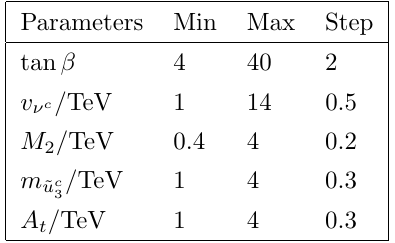
Table 2 . Scanning parameters for the Higgs boson decay h